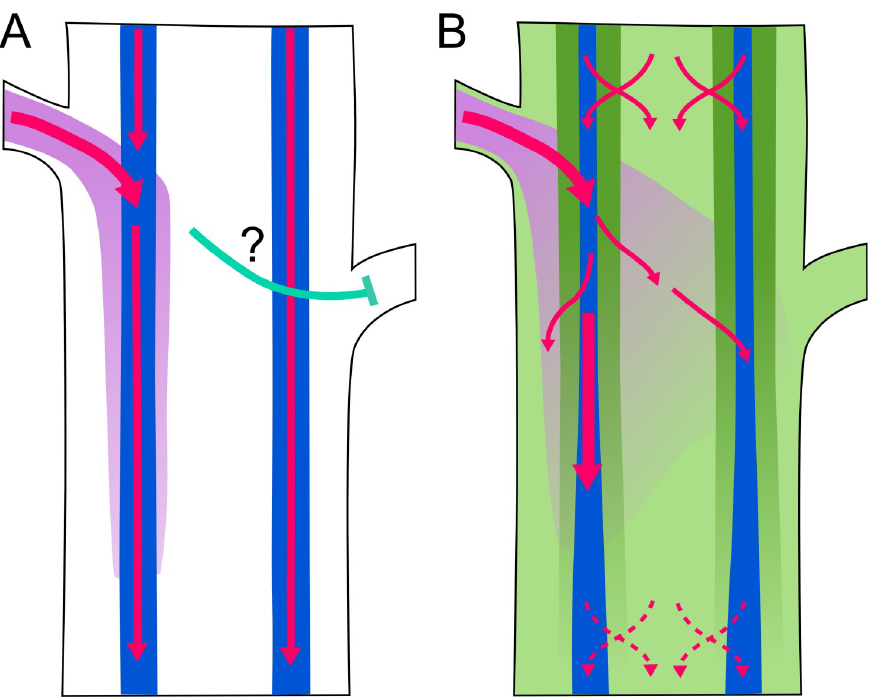
Fig 10. Two proposed models of auxin transport in an Arabidopsis stem. Image reproduced under CC-BY 4.0 license, credit: 10.1371/journal.pbio.1002446.